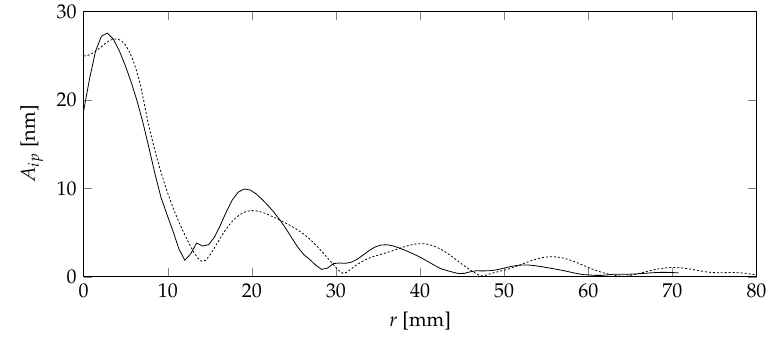
Figure 15. Simulated out-of-plane amplitude (dashed) and measured out-of-plane amplitude